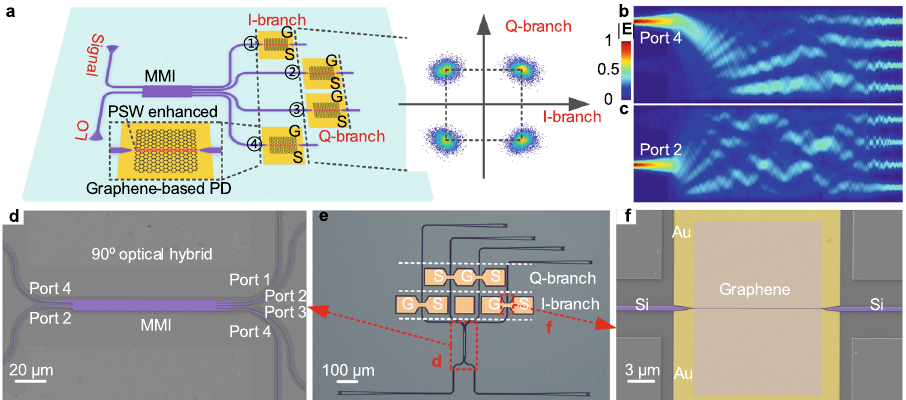
Fig. 1 The OCR with graphene on PSW. a Schematic diagram of the proposed graphene-based OCR. GS electrodes: ground-signal electrodes. b , c The mode pro fi le of the MMI coupler under the light input from port 4 ( b ) and port 2 ( c ), respectively. d False-color SEM image of the MMI coupler (90-degree optical hybrid). e Optical microscopy image of the proposed OCR. The image was taken before transferring graphene to the device. f False-color SEM image of a graphene-on-PSW PD.